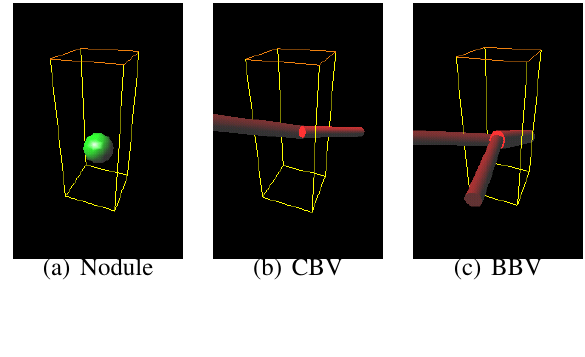
Figure 8. The most likely nodule, curved blood vessel and bifurcated blood vessel models for the nodule shown in Figure